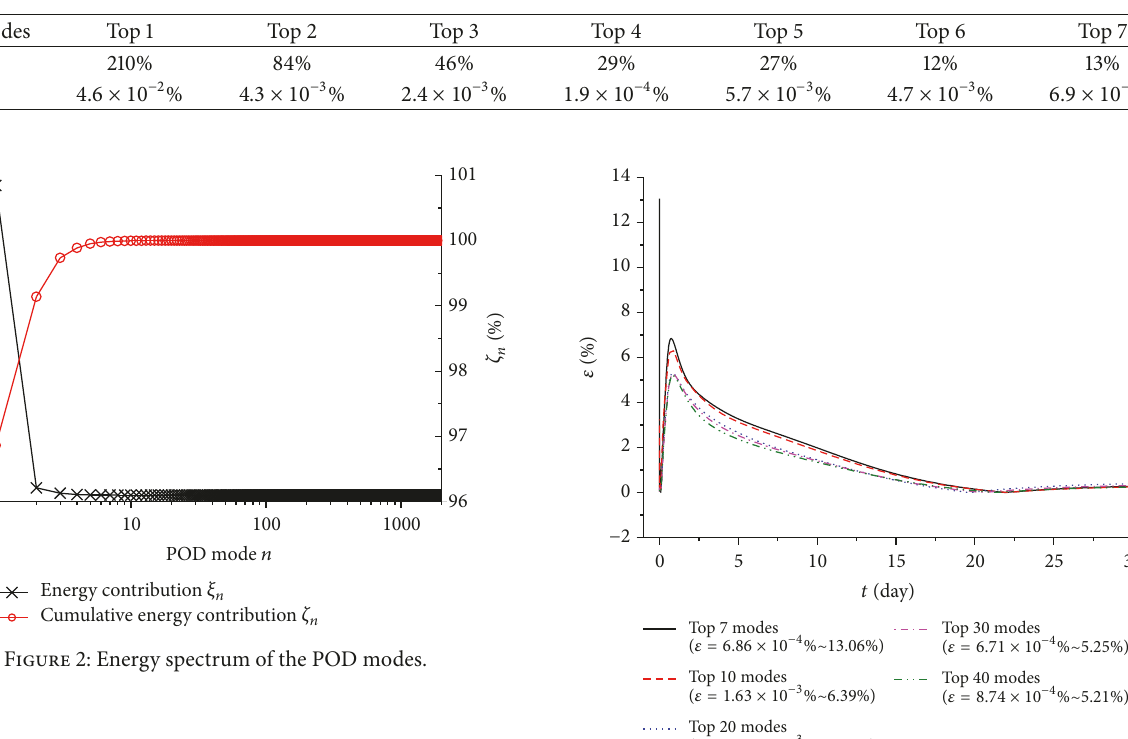
Table 2: Reconstruction deviations using top 1 ∼ top 7 modes.